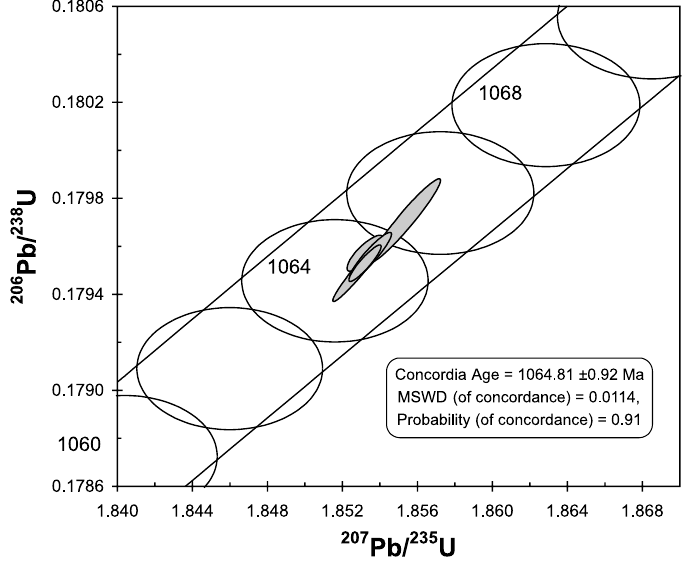
Fig. 2 – The U-Pb concordia diagram for 91500 standard using 235 U- 205 Pb “ B” spike.